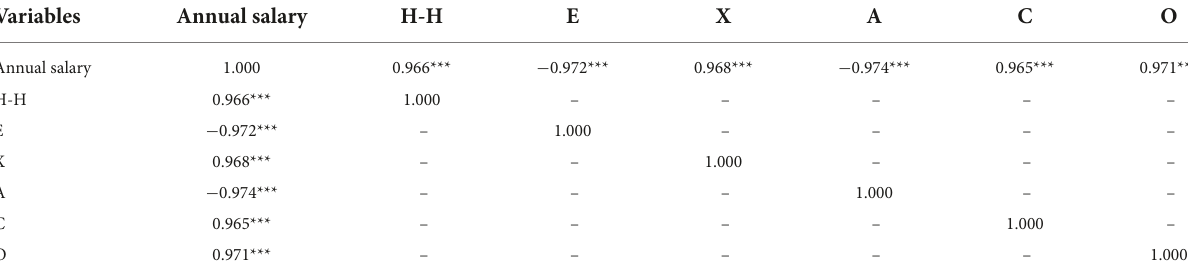
TABLE 4 The bivariate correlation of employees’ personality traits and their annual